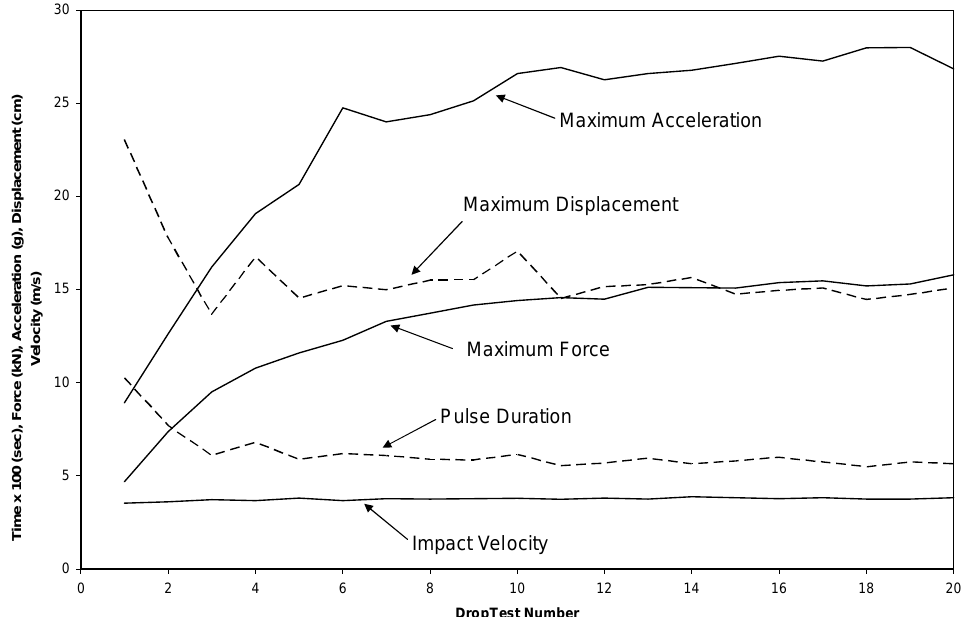
Fig. 7. Sequence of 20 dynamic tests on new Amsteel Blue rope; weight = 289 N, height = 196